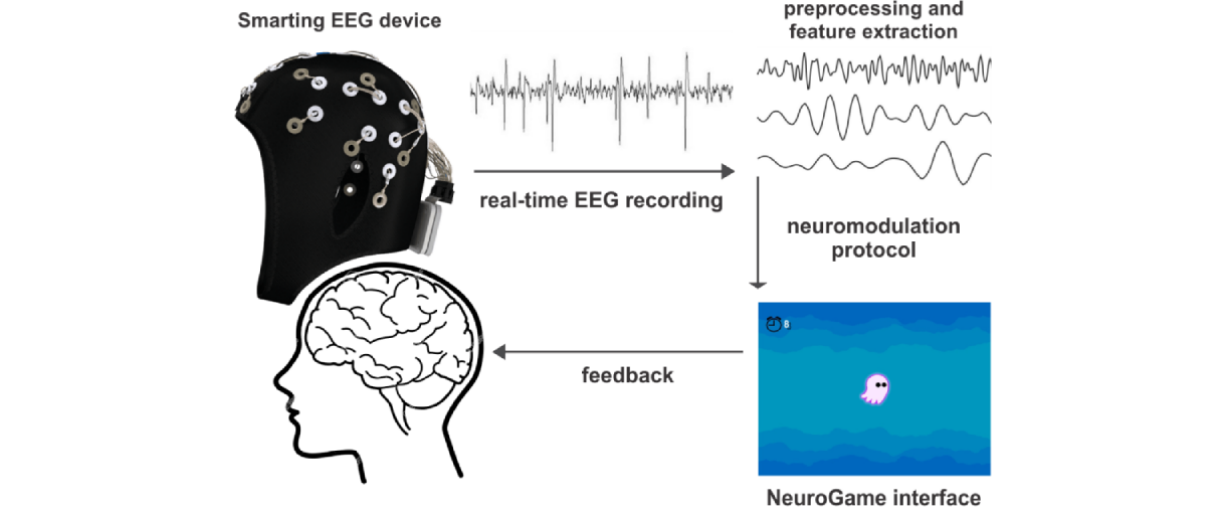
Figure 2. Neurofeedback loop of the brain-computer interface-based neuromodulative intervention (Floating Jellyfish). EEG: